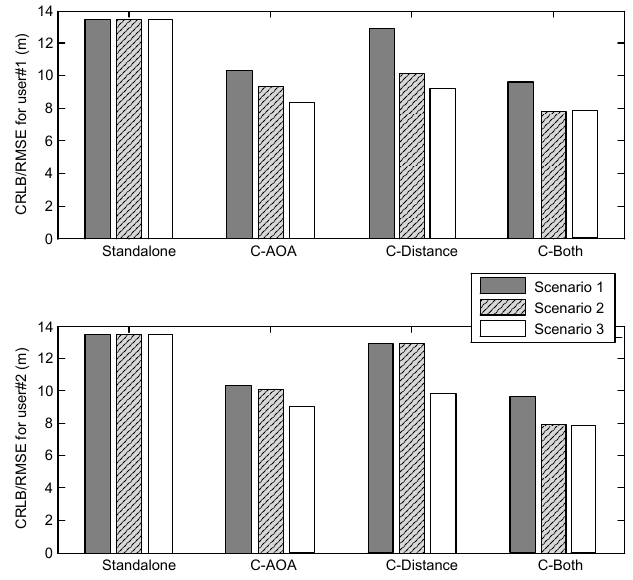
Figure 8. The impact of new collaborative link and